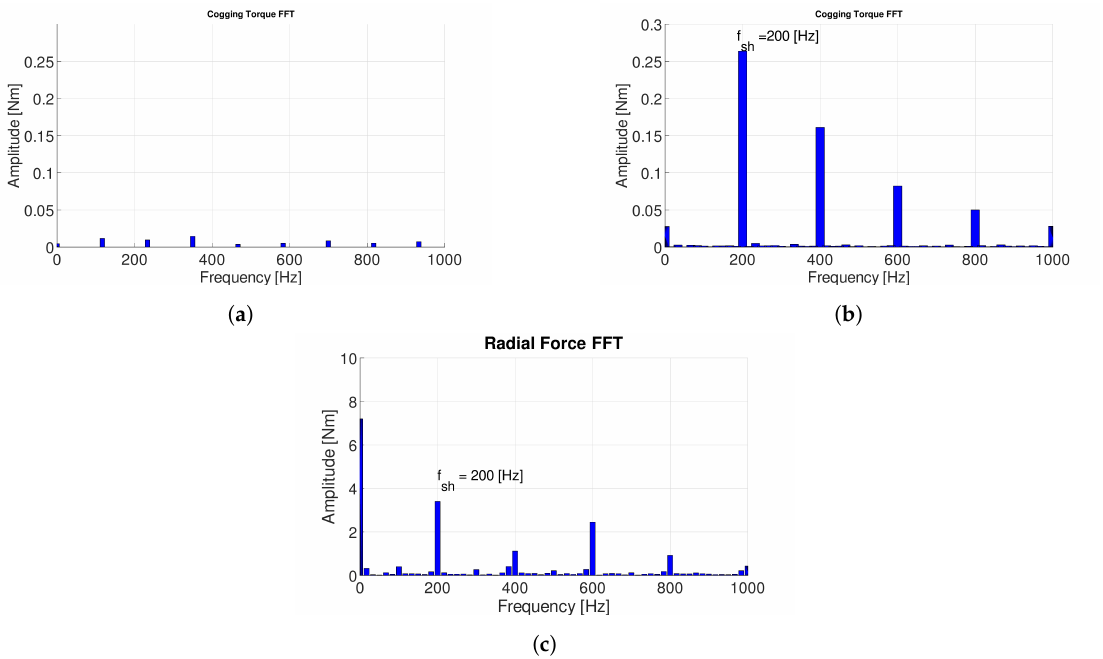
Figure 9. Cogging torque FFT of 12-14DL: in healthy condition ( a ); with magnets dislocation ( b ); and with radial force FFT with magnet dislocation ( c